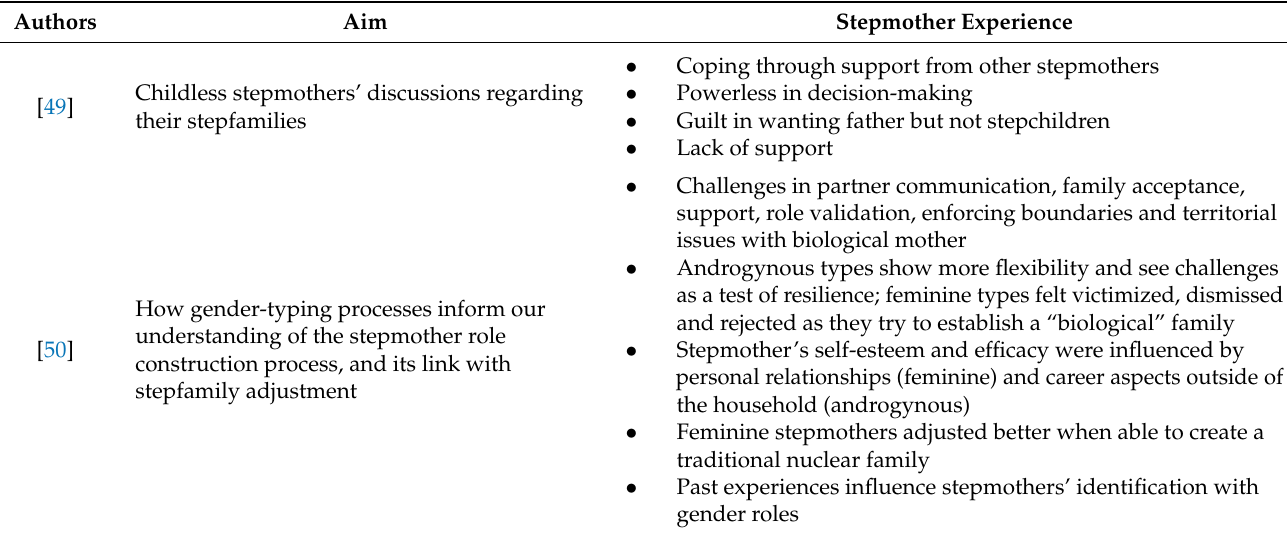
Table 3. Stepmother